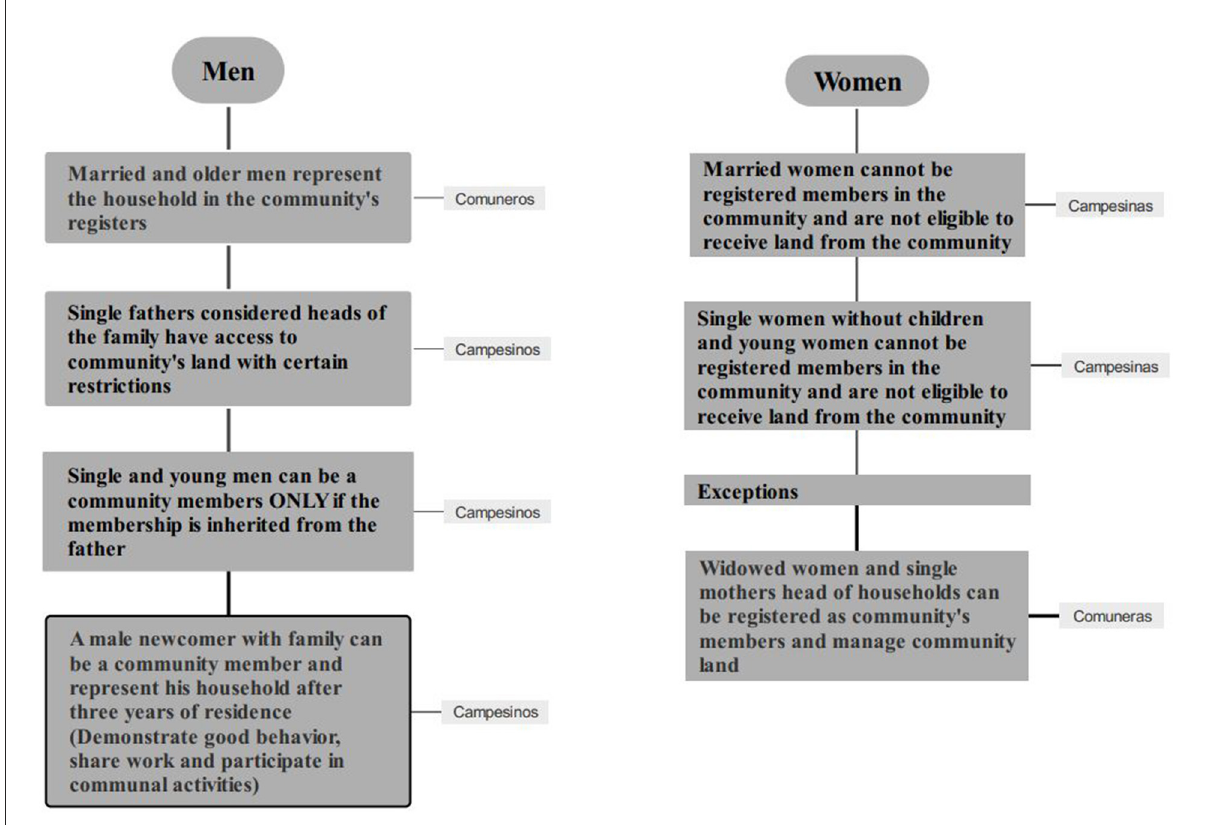
FIGURE3 Community land